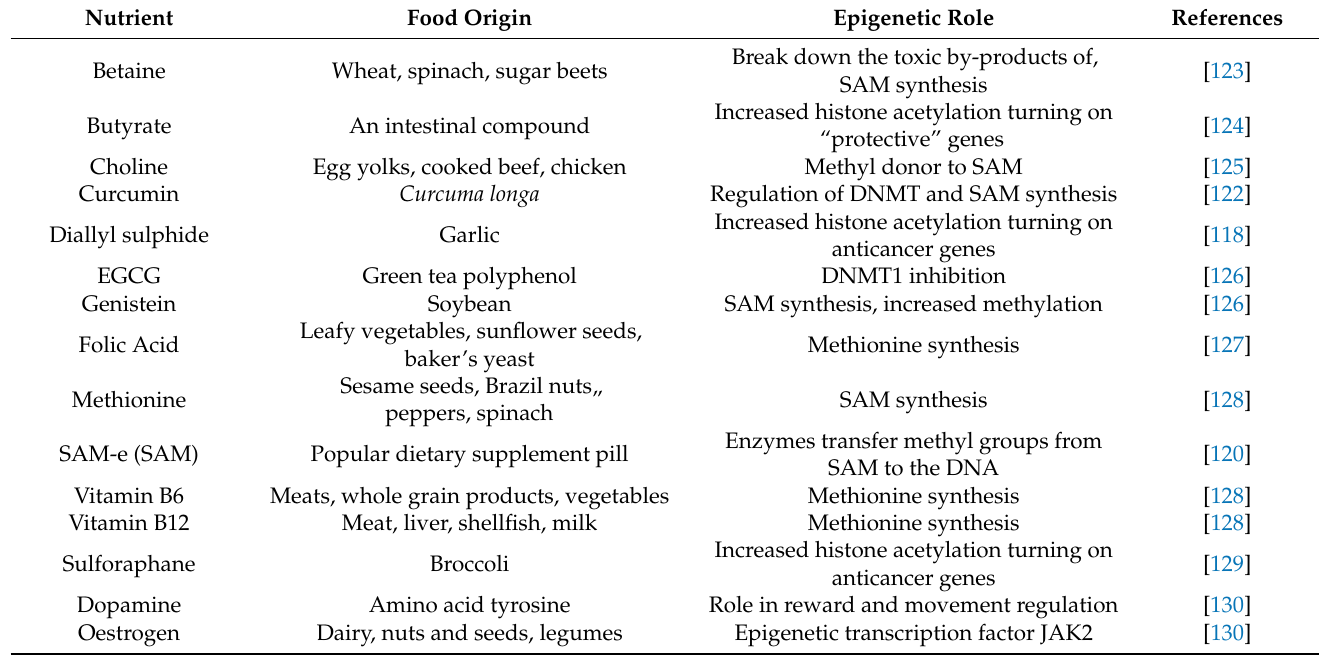
Table 2. Dietary components contribute to providing protection against cancers and their mechanism of